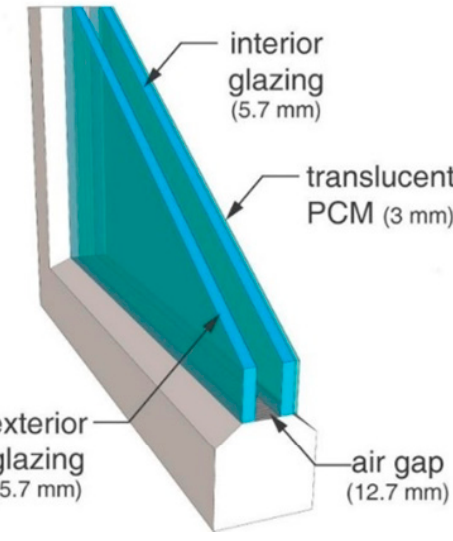
Figure 11. Schematic of DG system [40].